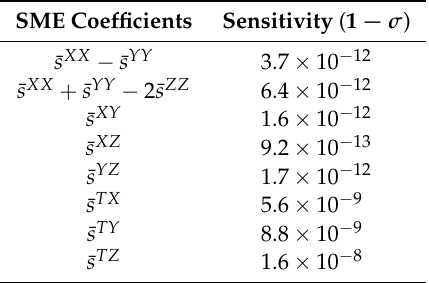
Table 11. Sensitivity of the SME coefficients to the observations of 360,000 asteroids by the Gaia satellite during a period of 5